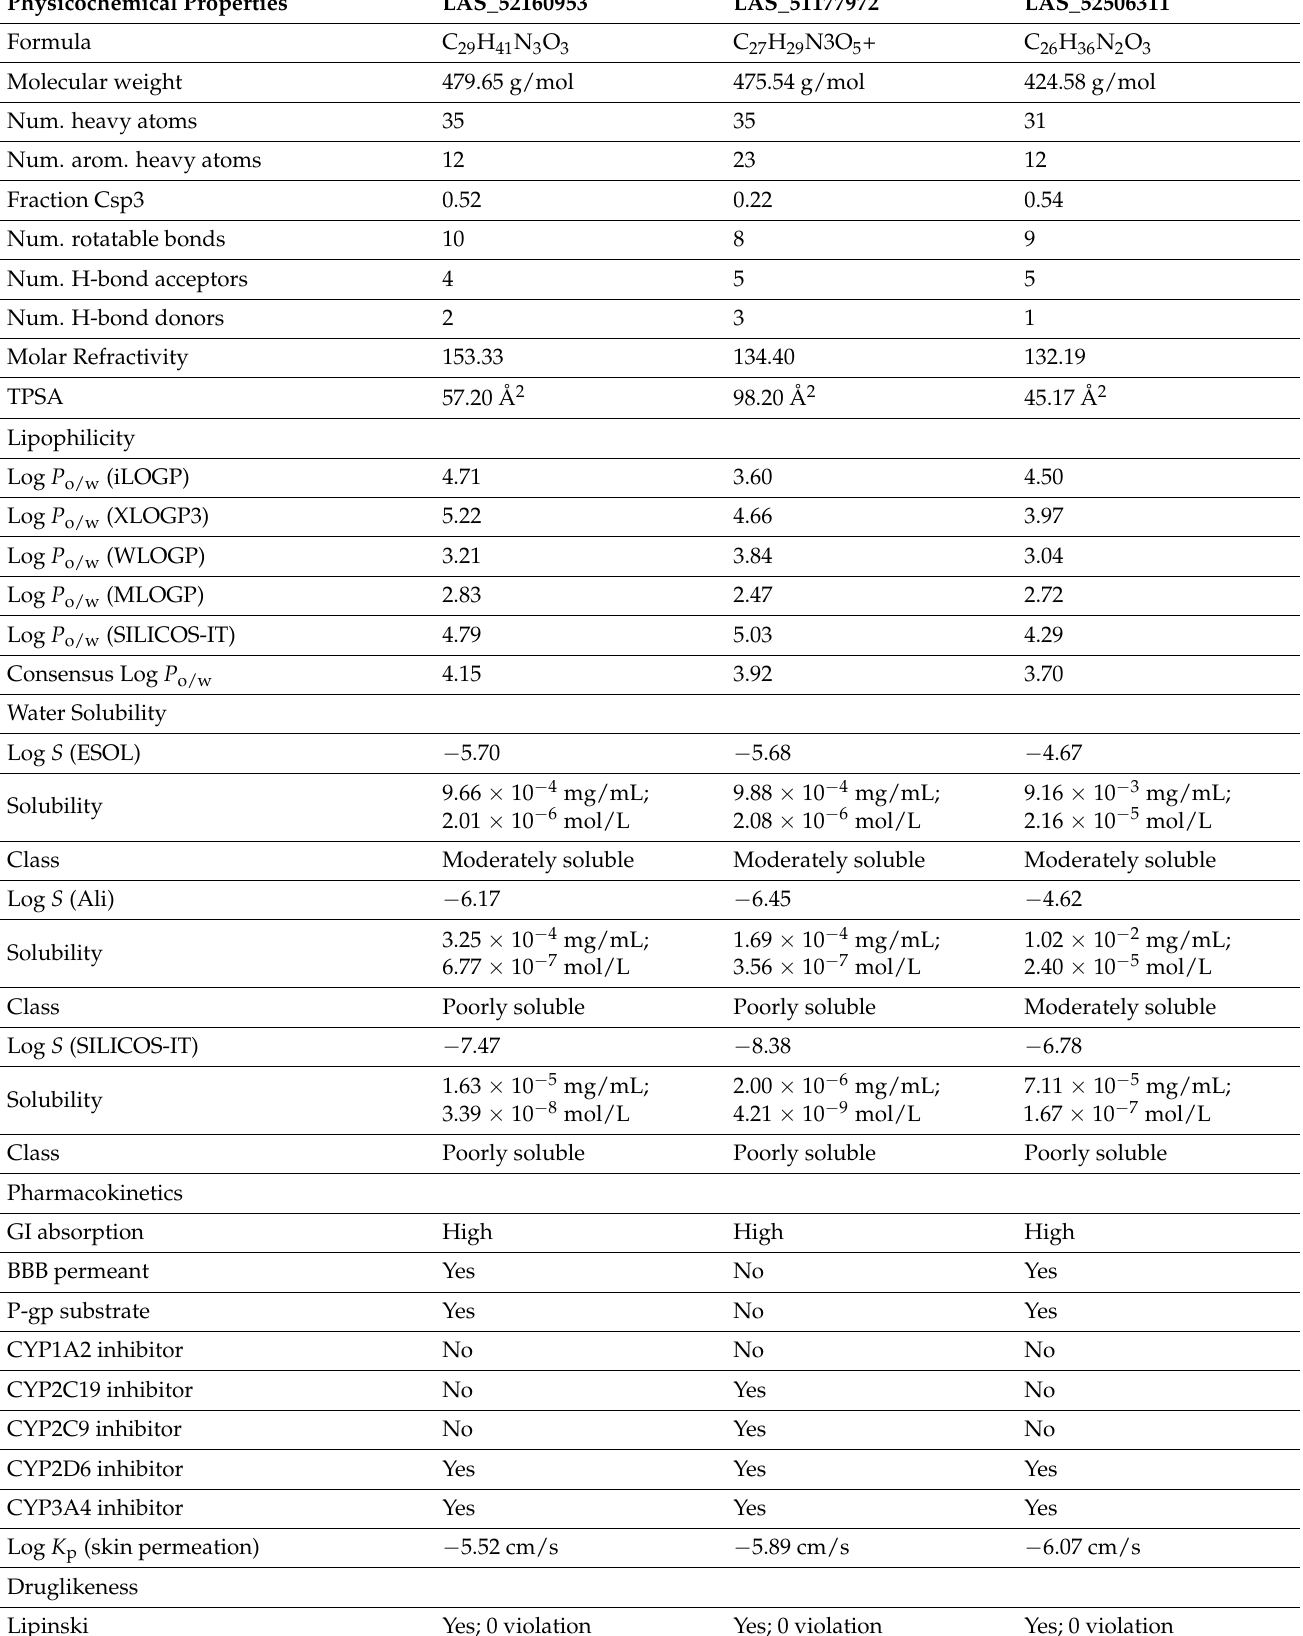
Table 3. SwissADME analysis of compounds. # stands for